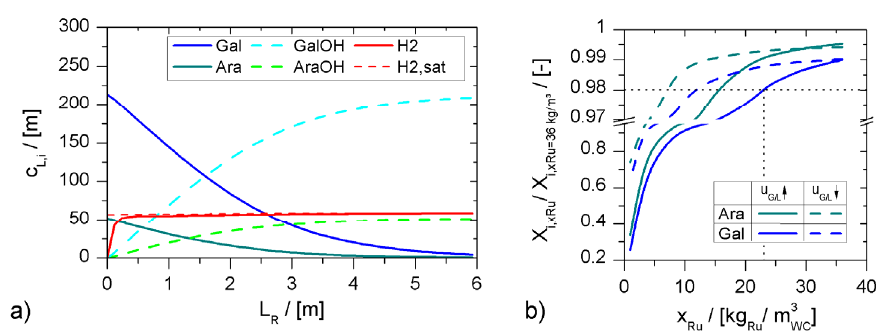
Figure 5. ( a ) Axial concentration profiles of all components in the liquid phase within the minichannel wall reactor at 𝑢 (cid:3013),(cid:3046) = 0.68 m/s , 𝑢 (cid:3008),(cid:3046) = 0.23 m/s , 𝑥 (cid:3019)(cid:3048) = 23.0 kg (cid:2902)(cid:2931) /m (cid:2907)(cid:2887)(cid:2871) , and ( b ) the effect of re- duced ruthenium content on the conversion of both reactants for high throughput (𝑢 (cid:3008)/(cid:3013) ↑ : 𝑢 (cid:3013),(cid:3046) = 0.68 m/s , 𝑢 (cid:3008),(cid:3046) = 0.32 m/s , 𝐿 (cid:3019) = 5.93 m ) and low throughput (𝑢 (cid:3008)/(cid:3013) ↓ : 𝑢 (cid:3013),(cid:3046) = 0.02 m/s , 𝑢 (cid:3008),(cid:3046) = 0.005 m/s , 𝐿 (cid:3019) = 0.62 m ).